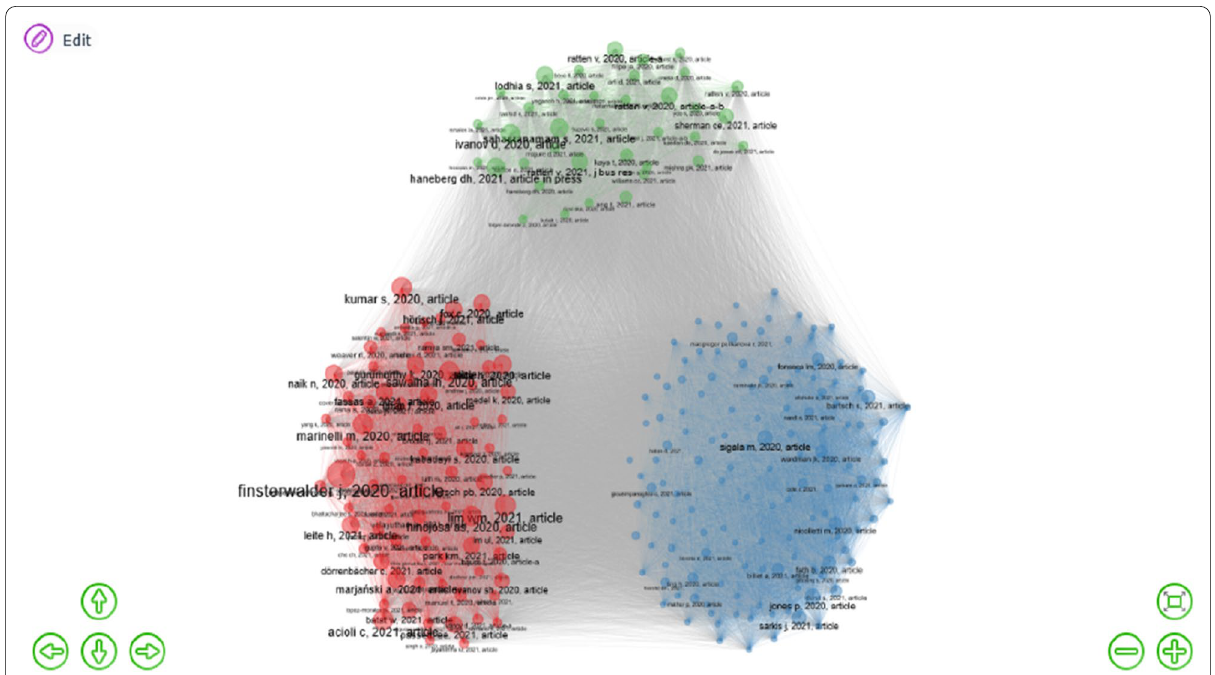
Fig. 8 Cluster analysis of